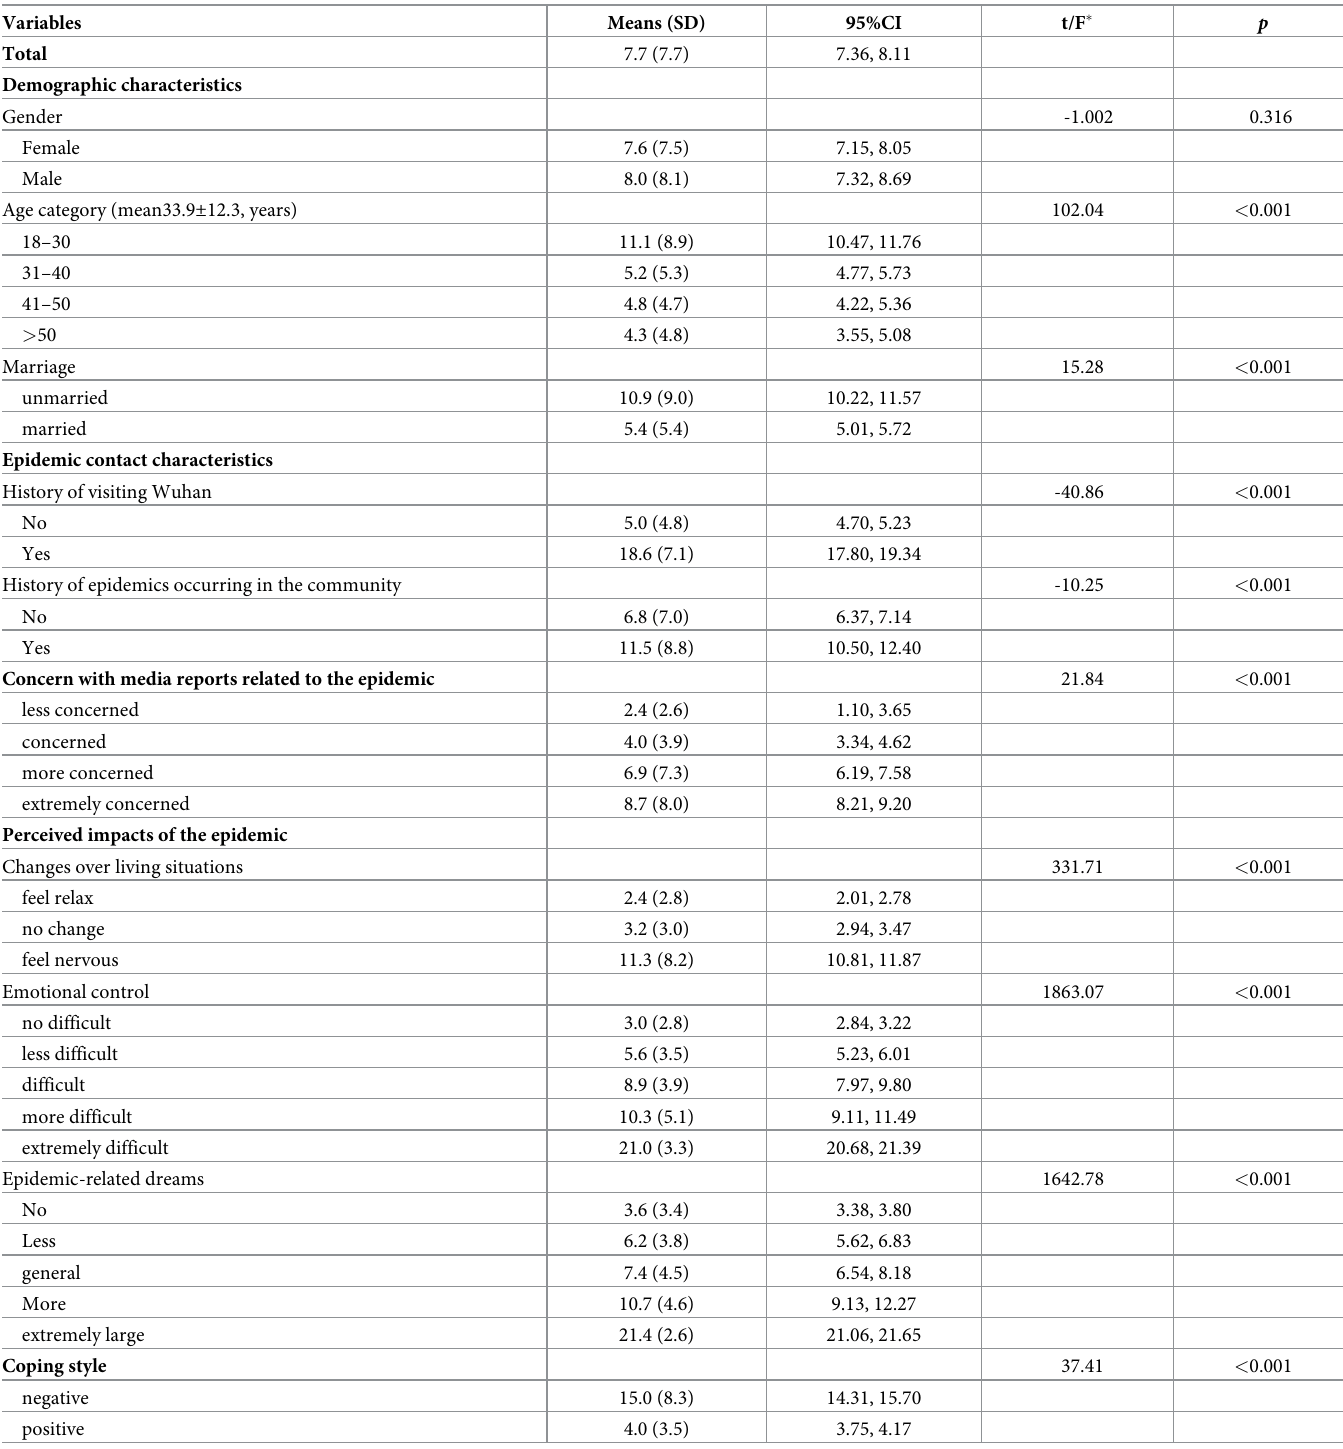
Table 2. Psychological distress (K6 scores) of participants (n =